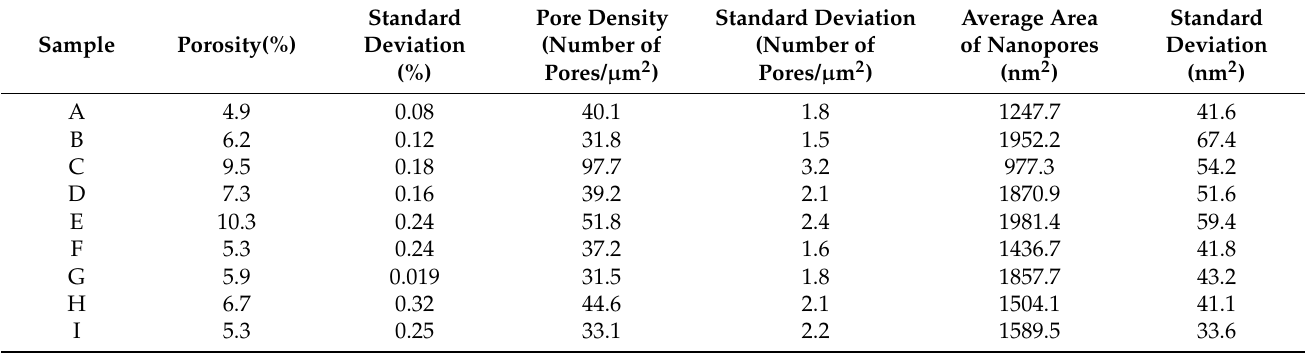
Table 3. Values of stereological parameters from computer image